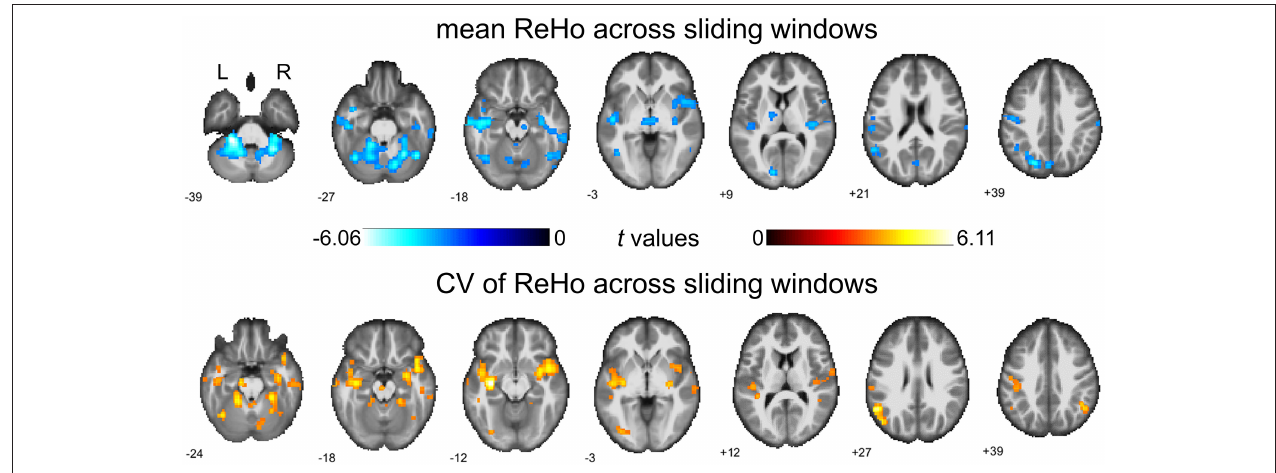
FIGURE 1 | Between-group comparisons of mean dReHo and coefficient of variation (CV) of ReHo across sliding windows (without global signal regression). Both significantly decreased mean dReHo (top row) and increased CV of ReHo (bottom row) were found in the left temporal pole (TPO.L), left middle temporal gyrus (MTG.L). The warm color represents an increase and the cold color represents a decrease when comparing children with BECTS with HCs. These results were voxel-wise p < 0.001, cluster level p < 0.05, family-wise error (FWE) cluster-level corrected, and minimum cluster > 20